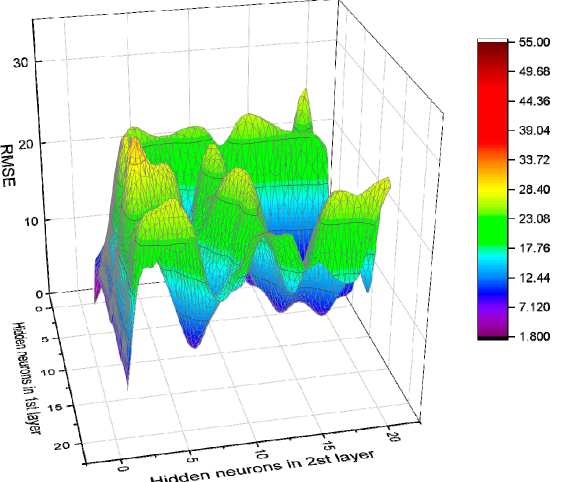
Figure 20. RMSE value of BPNN model based on Log-Sigmoid (double hidden layers).